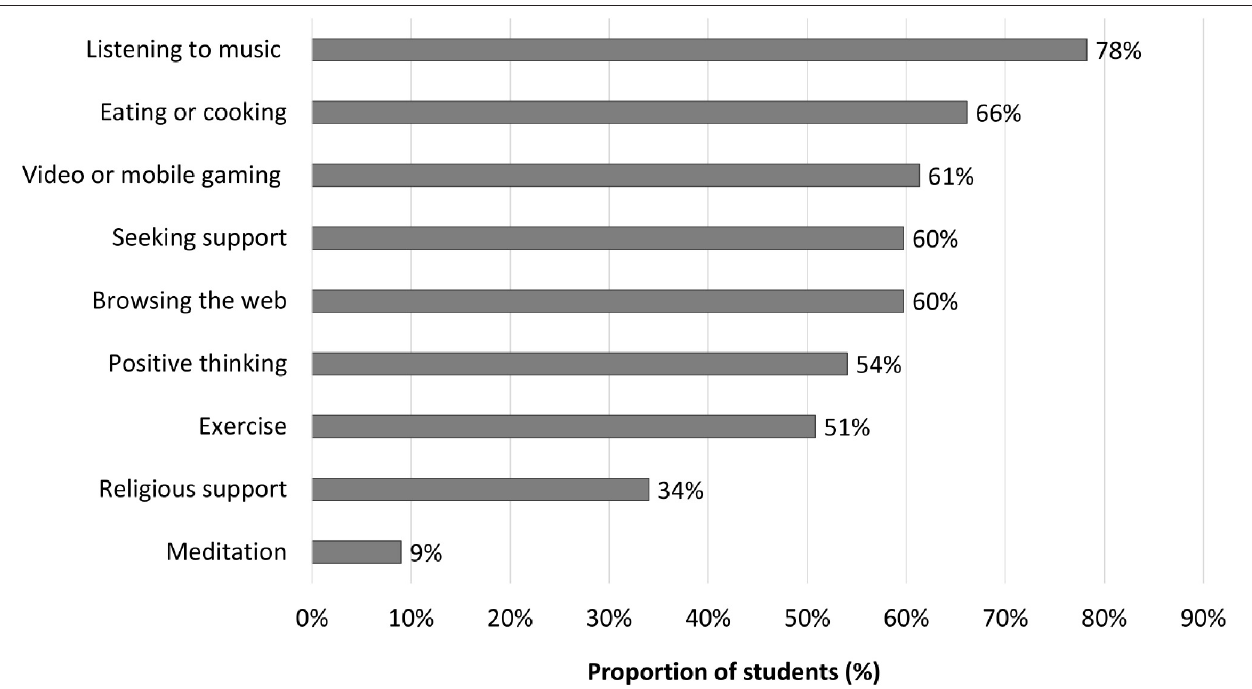
FIGURE 2 | Coping strategies in response to coronavirus disease 2019 (COVID-19) for the total student